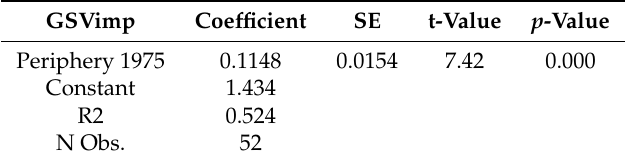
Table 2. Landscapes of impoverishment and the historical urban